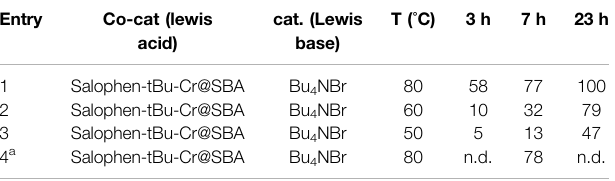
TABLE 2| Yield (%) ofstyrene carbonate obtained with Salophen-tBu-Cr@{NH 2 }- SBA-15 Entry